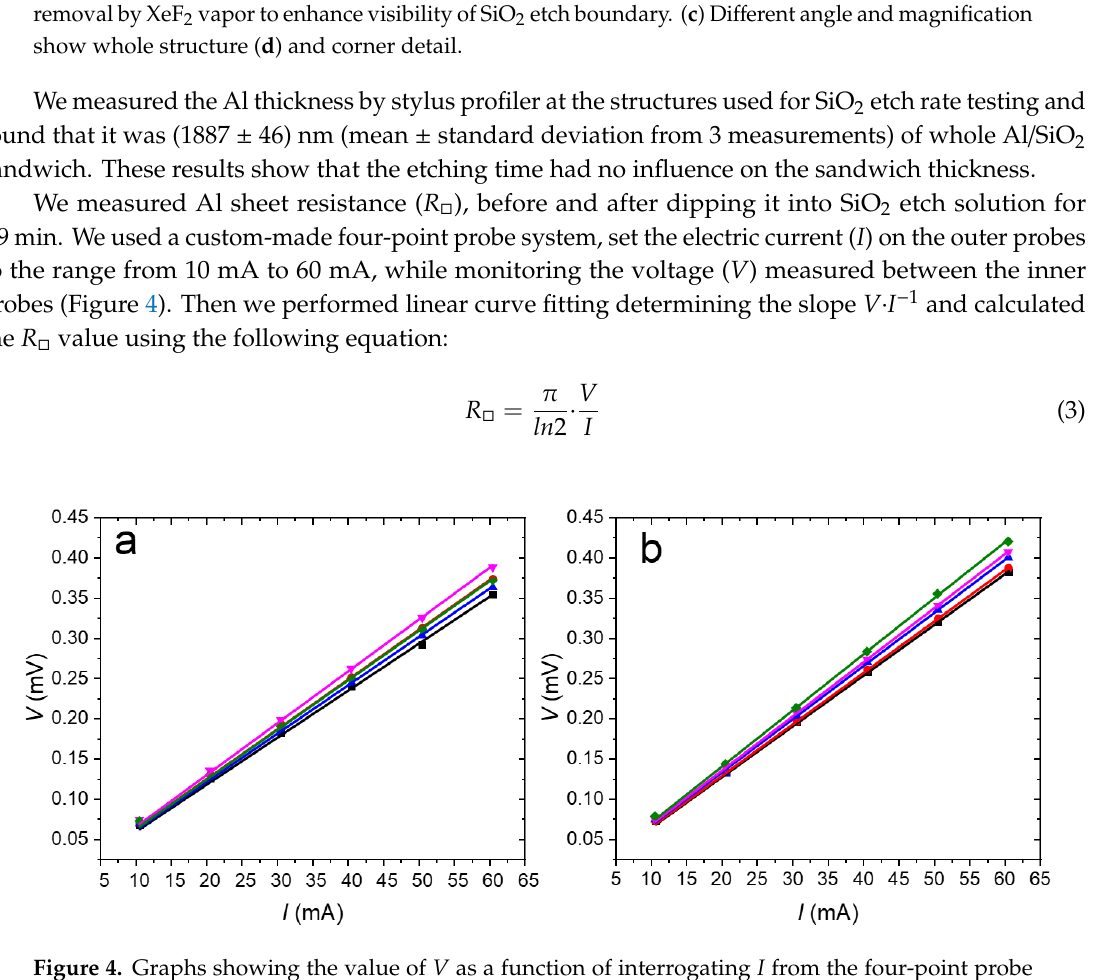
Figure 4. Graphs showing the value of V as a function of interrogating I from the four-point probe system at Al layer before ( a ) and after ( b ) dipping in SiO 2 etch solution. The fitted slope V ∙ I −1 with an assumption of intercept of 0 V changed by ≈7.5%.